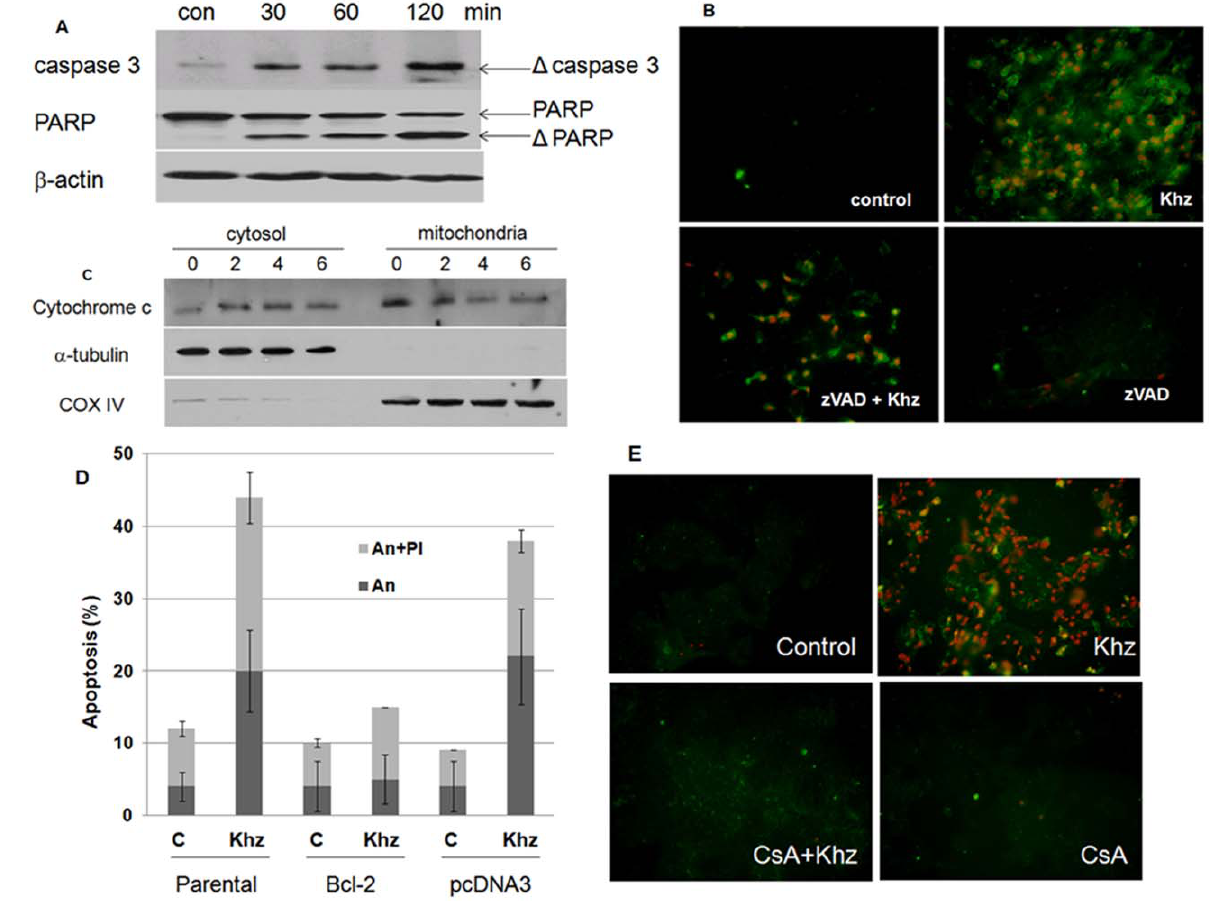
Figure 3. Khz induces apoptosis through a mitochondrial pathway. (A) HepG2 cells were treated with a 1:2 dilution of Khz, and caspase or PARP activation was analyzed by immunoblotting. (B) Cells were pretreated with z-VAD-fmk (20 m M) for 1 h and treated with Khz at the